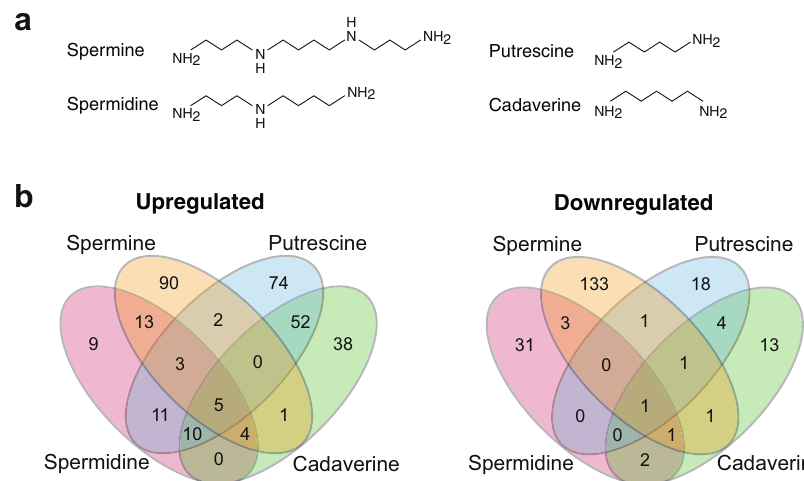
Fig. 1 Distinct regulons of spermine, spermidine, putrescine and cadaverine. a Structures of the four polyamines used in this study. b Venn diagram of upregulated and downregulated gene sets. Note that some targets showed expression changes in opposite directions following treatment with different polyamines, as shown in Supplementary Fig.